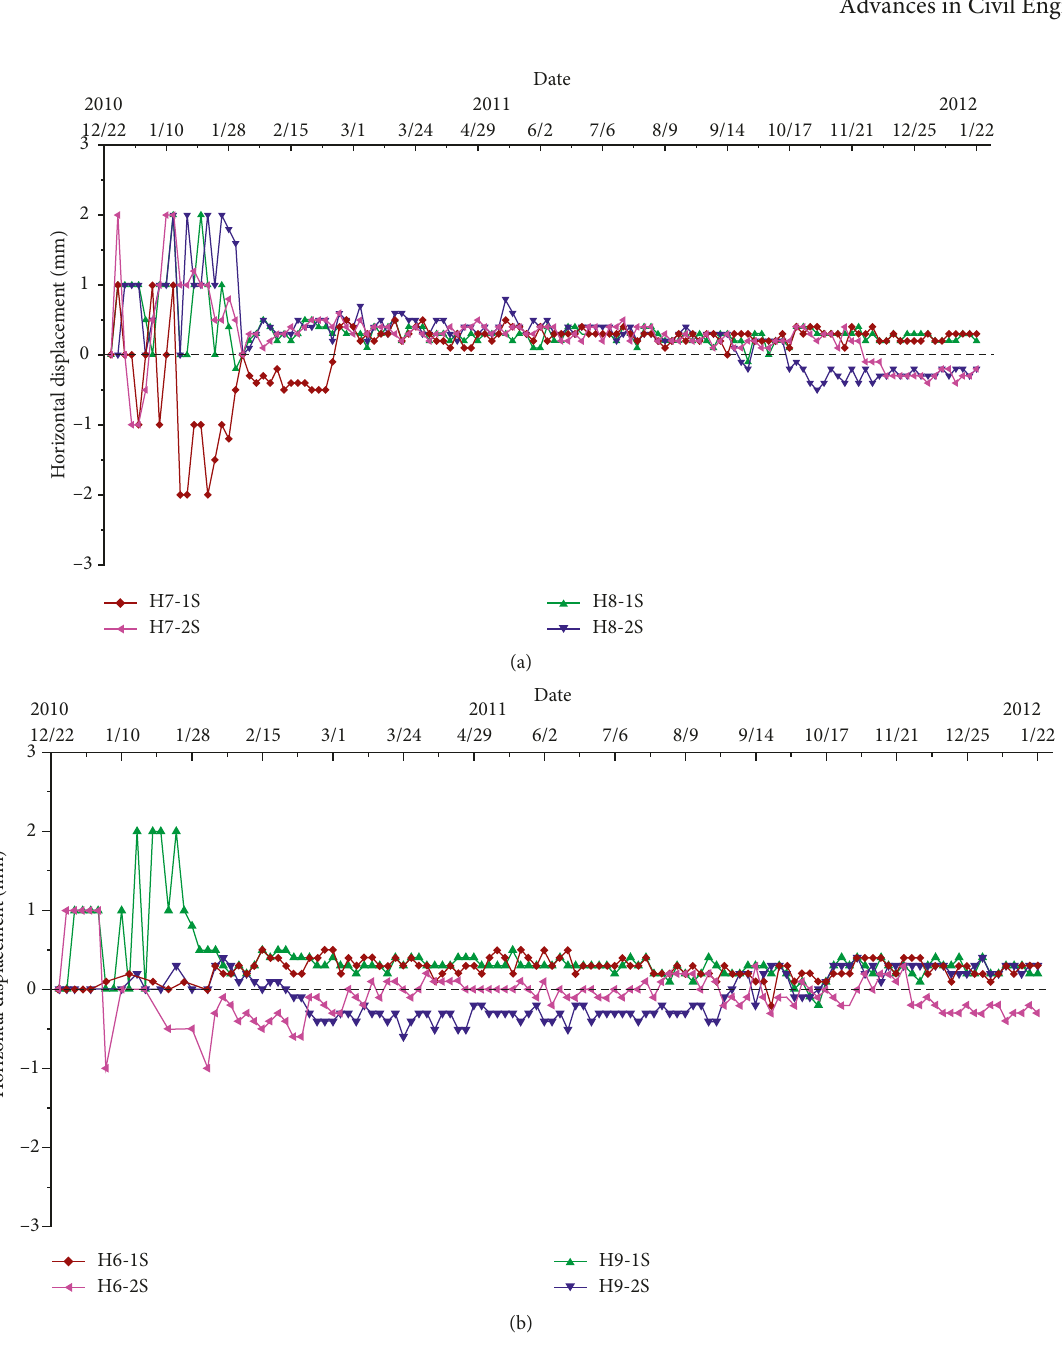
Figure 13: Horizontal displacement curve of pier: (a) S7 and S8; (b) S6 and